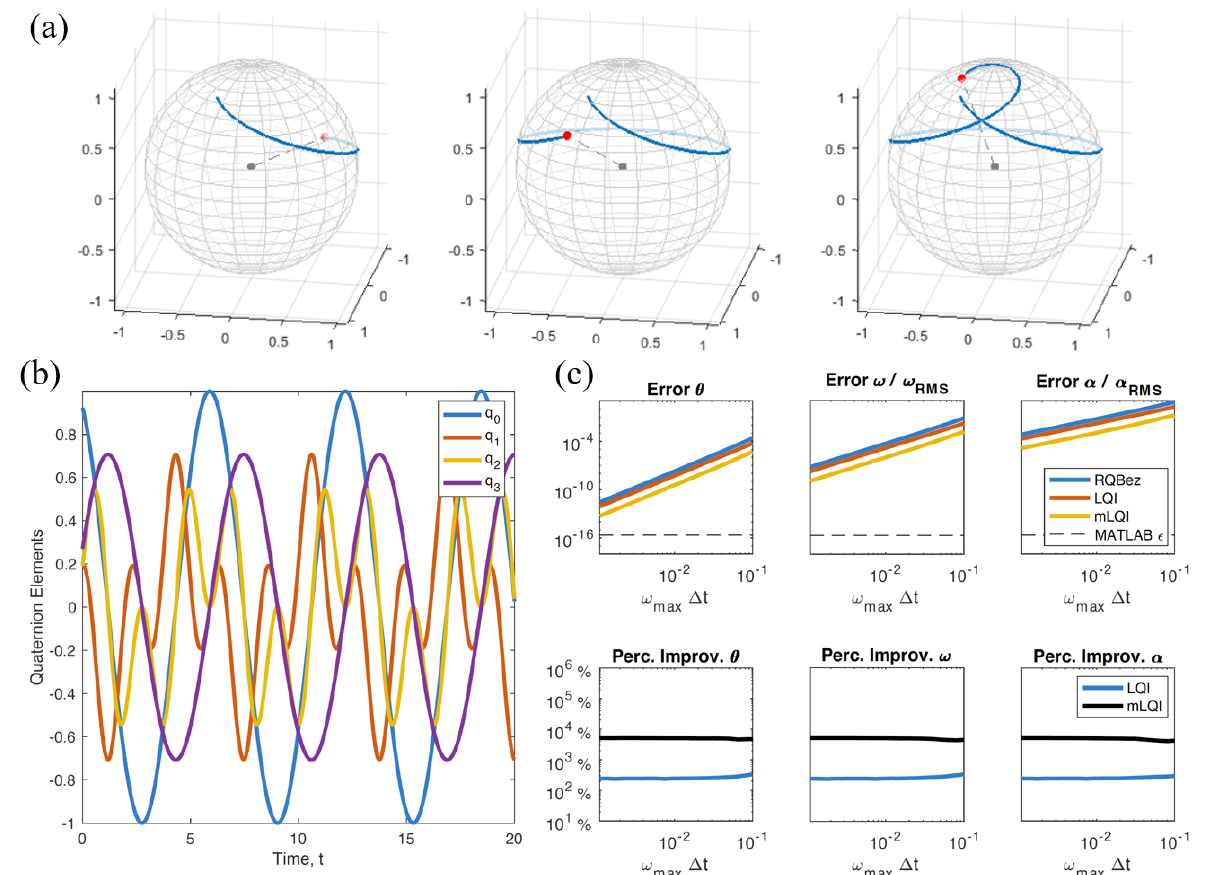
Figure 3. ( a ) The rotational motion of ˆ r 0 = ˆ z as a result of constant rotation in the quaternion angle as well as a constantly rotating unit vector. ( b ) What the quaternion elements themselves look like. Here, ω θ = ω φ = 2 rad . The compounding of two simple rotations results in more complex s behavior than example one ( c ) Error in the angle θ , the magnitude of angular momentum (cid:107) (cid:126) ω (cid:107) , and magnitude of the angular acceleration α , both in absolute magnitude and relative to RQBez. LQI outperform RQBez by over two orders of magnitude, and mLQI provides an additional two orders of magnitude